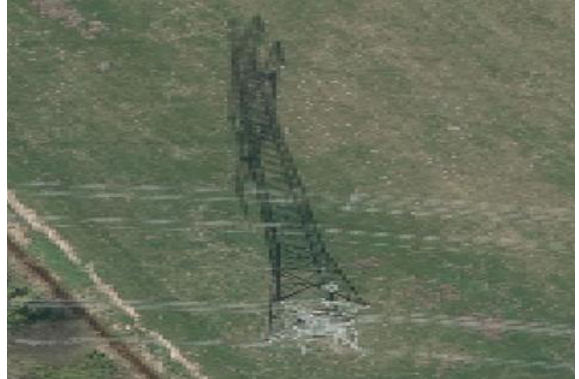
Figure 19. TrueDOP presentation of an electricity pylon